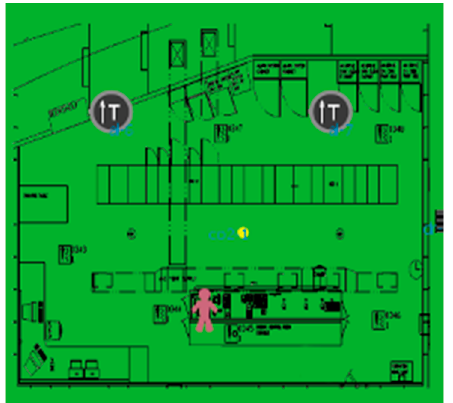
Figure 4. The ground plan of the control room of the engine room.